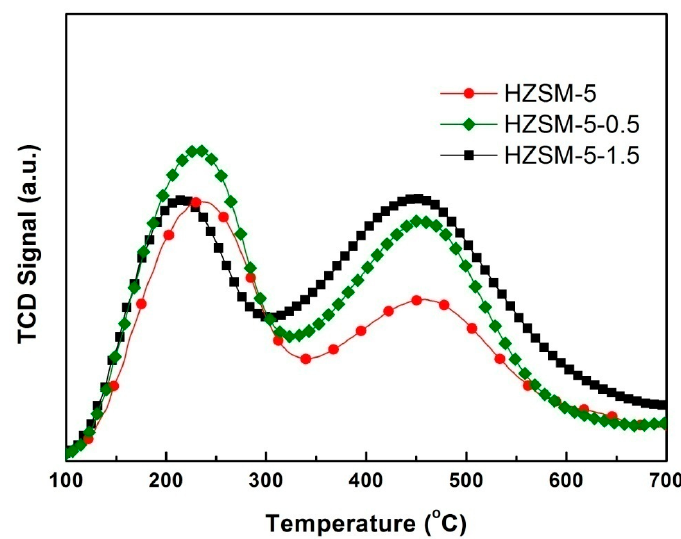
Figure 5. NH 3 -TPD profiles for parent HZSM-5 and the hierarchical HZSM-5 treated with different concentrations of NaOH solution (0.5 and 1.5 M) at 343 K for 1 h.